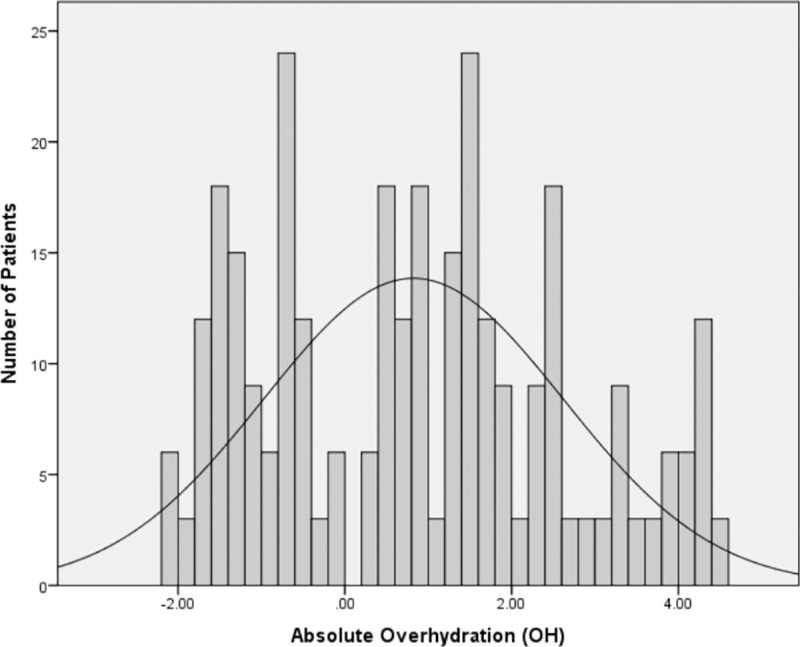
Distribution of absolute overhydration (0H) in 312 NDD-CKD patients, ranging between -2.1–4.4 L (82± 1.79).